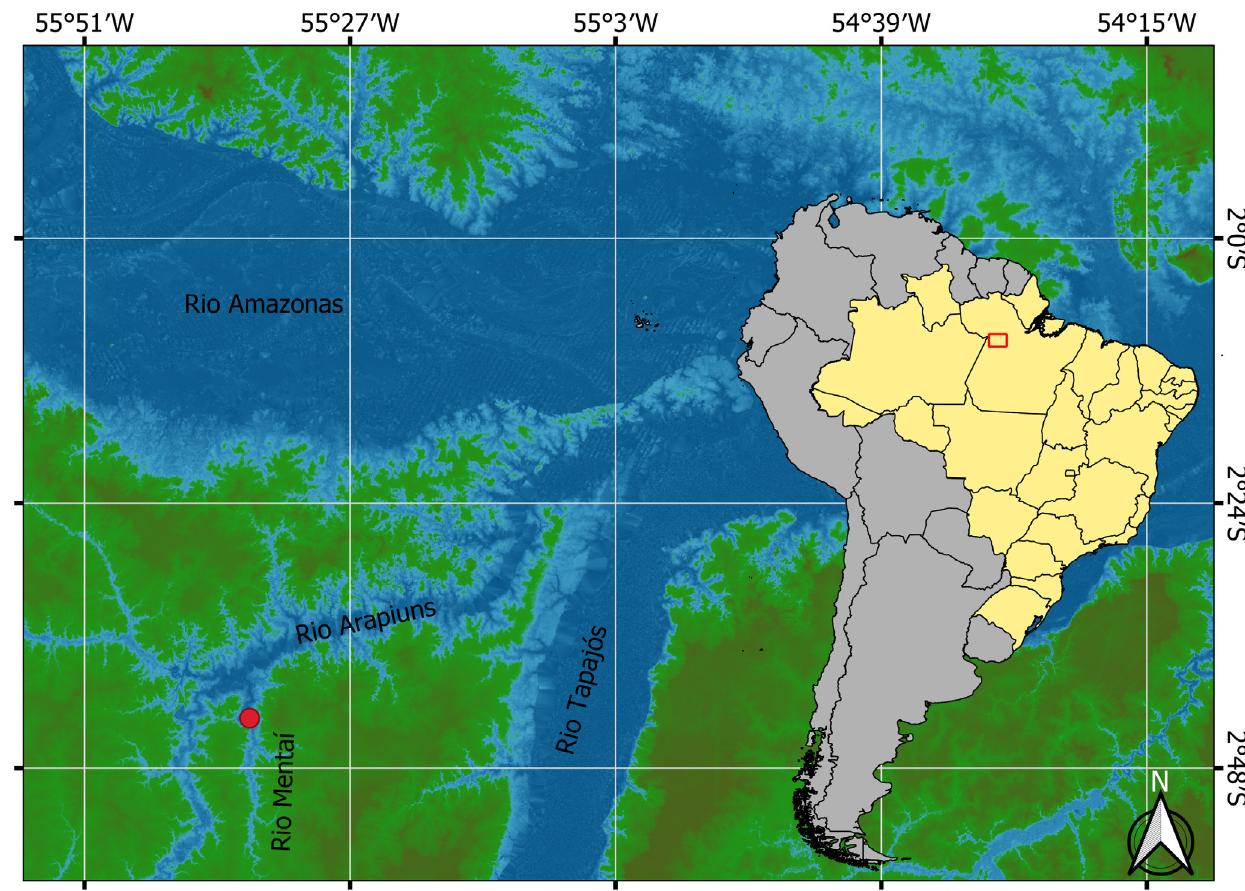
FIGURE 2 | Map of the lower Tapajós basin and its confluence with rio Amazonas showing the distribution of Cyphocharax cramptoni. The red dot indicates the type